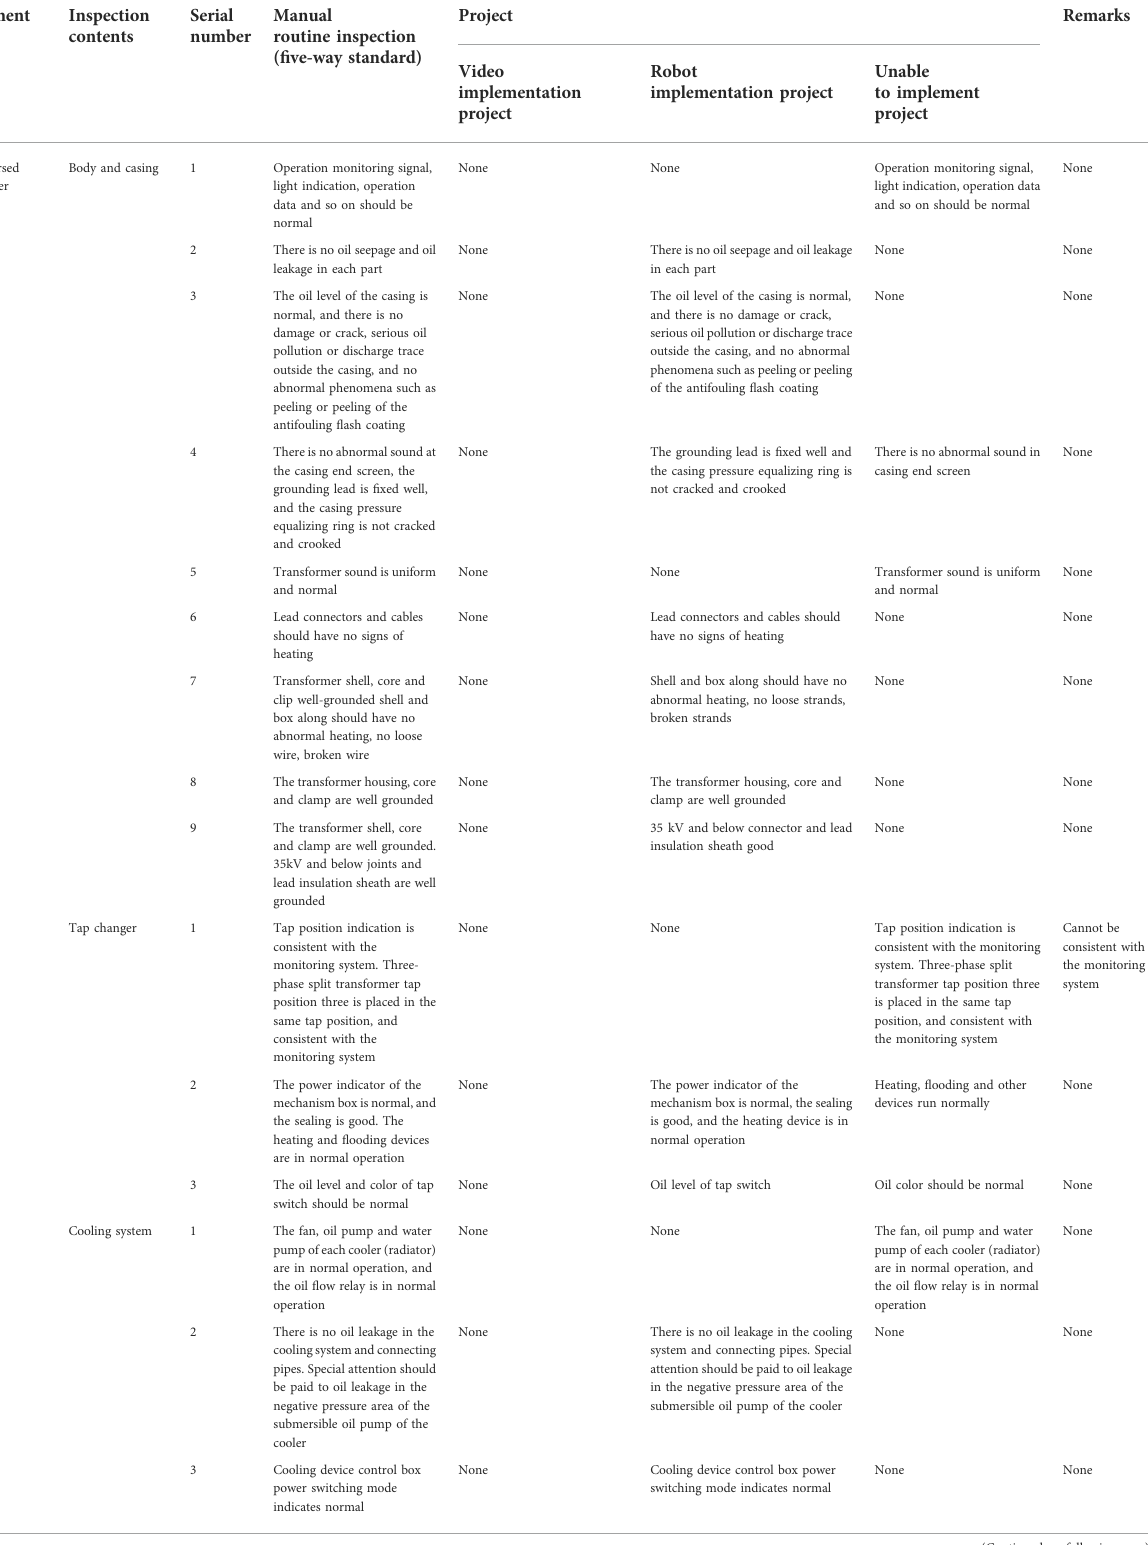
TABLE 1Comparison cardof routine inspection, video inspection and robot inspection of fi ve-way version of oil immersed transformer in substation in Southwest China. Equipment